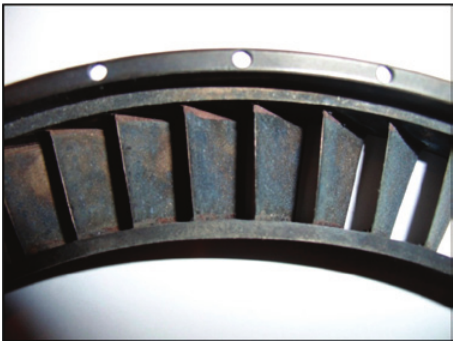
fig. 3. The stator of the GTE